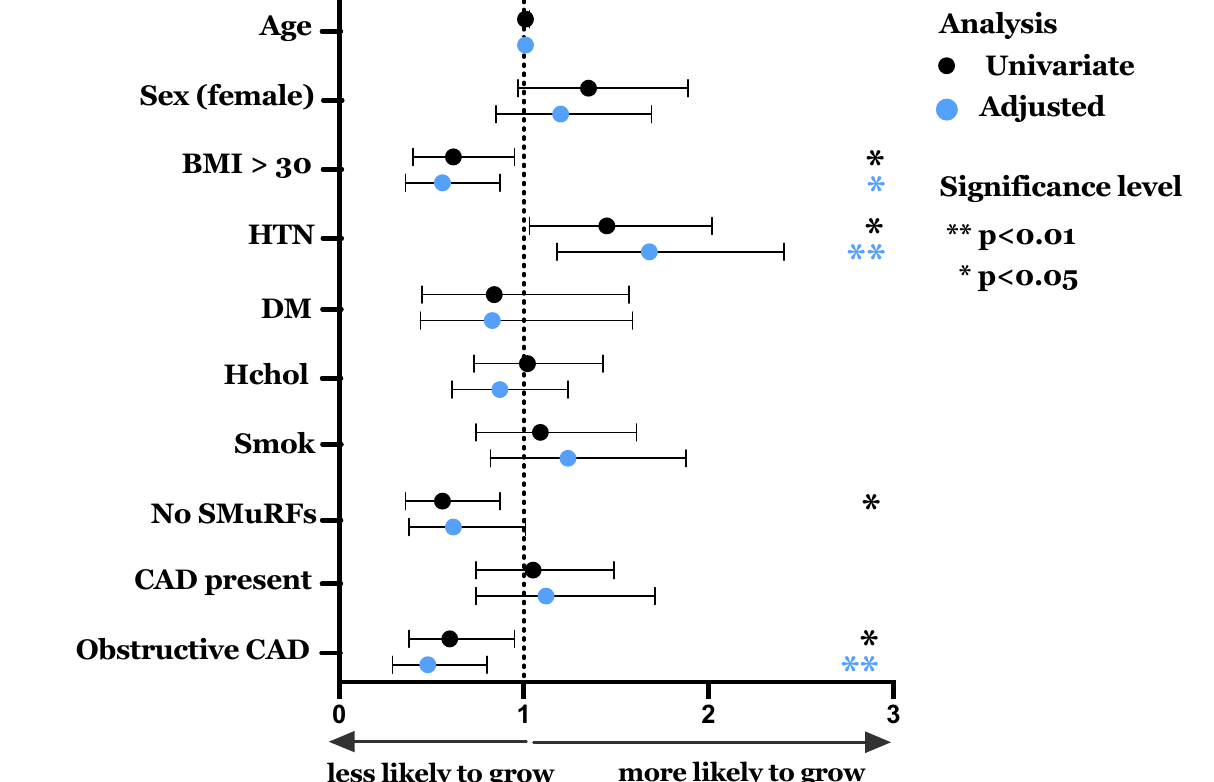
Figure 3. Odds ratios for association between clinical factors and successful ECFC Growth. Multivariable logistic regression models were performed, adjusting for age, sex and independent variables with p < 0.1 for univariate associations. Black dots represent univariate associations and blue dots represent adjusted odds ratios. Bars represent 95% confidence